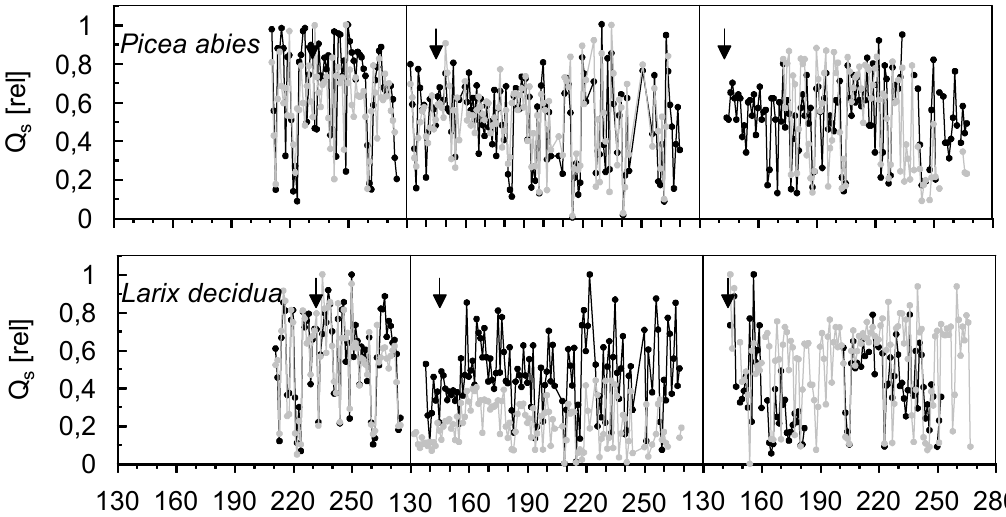
values > 4 hPa in P. abies and > 7 hPa in L. decidua saplings growing in control and rain exclusion plots, Figure 2. Seasonal course of daily mean normalized sap flow density ( Q s ) of Picea abies and Larix decidua saplings in the control (black) and rain exclusion plots (grey) from 10 July–2 October 2016, 18 May–27 September 2017, and 23 May–23 September 2018. Data are the mean of three saplings per treatment. Arrows indicate the start of rain exclusion.